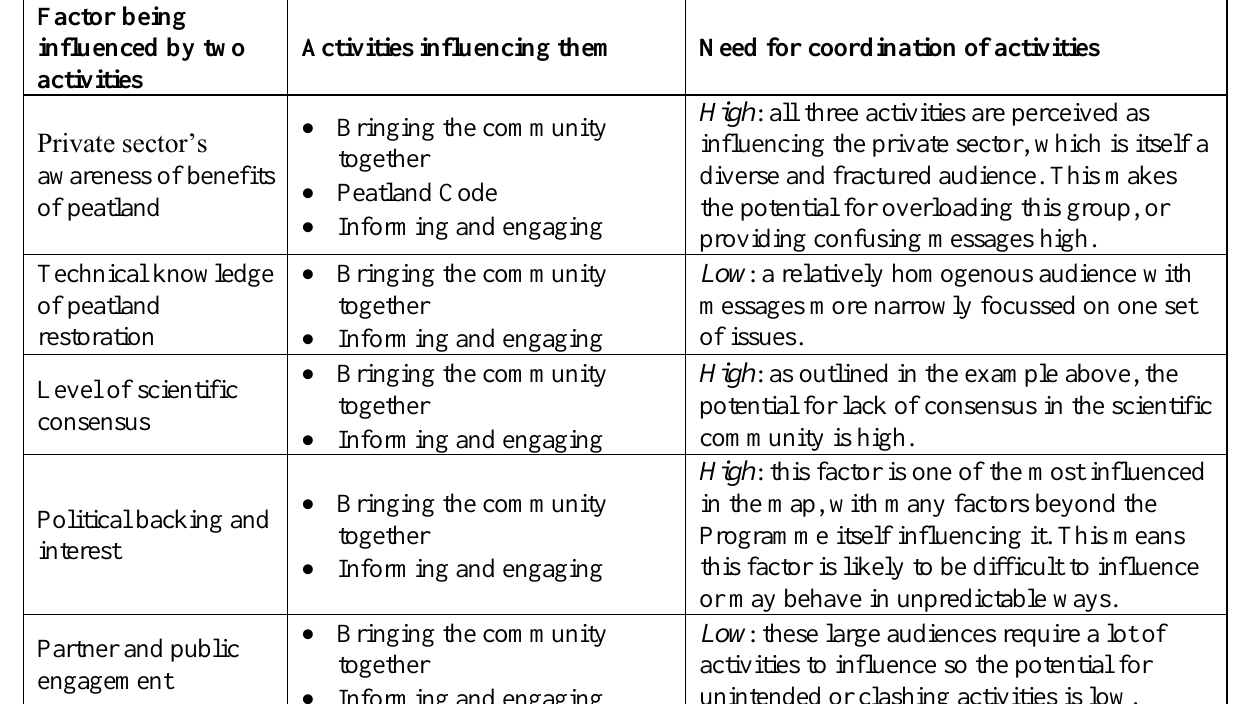
Table 1. Factors affected by two or more Peatland Programme